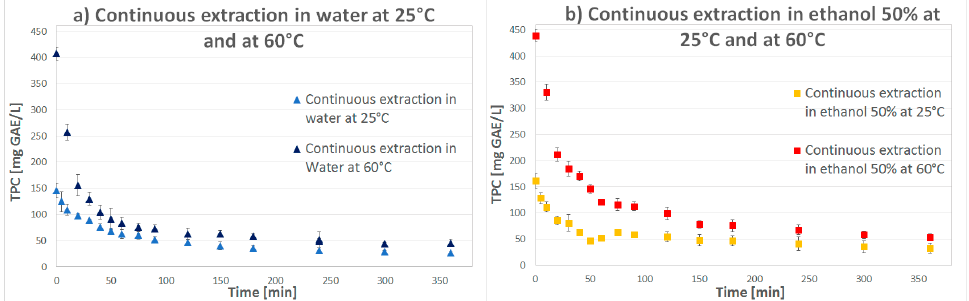
Figure 1. Total phenolic compound concentrations in continuous solvent extraction from seeds using ( a ) water ( b ) ethanol 50%.